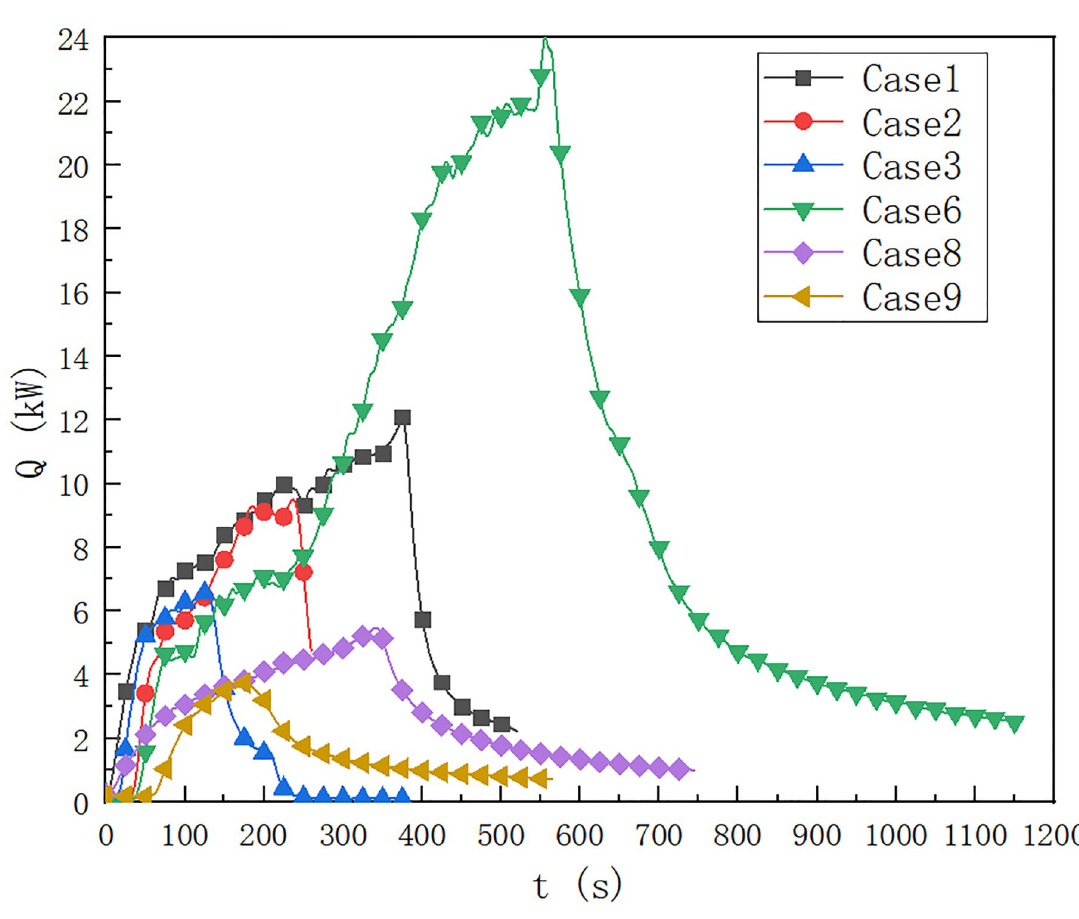
Fig 5. Prediction of fire HRR at 0.5 m from fire source in cable compartment of utility tunnel in cases of 1, 2, 3, 6, 8 and 9.